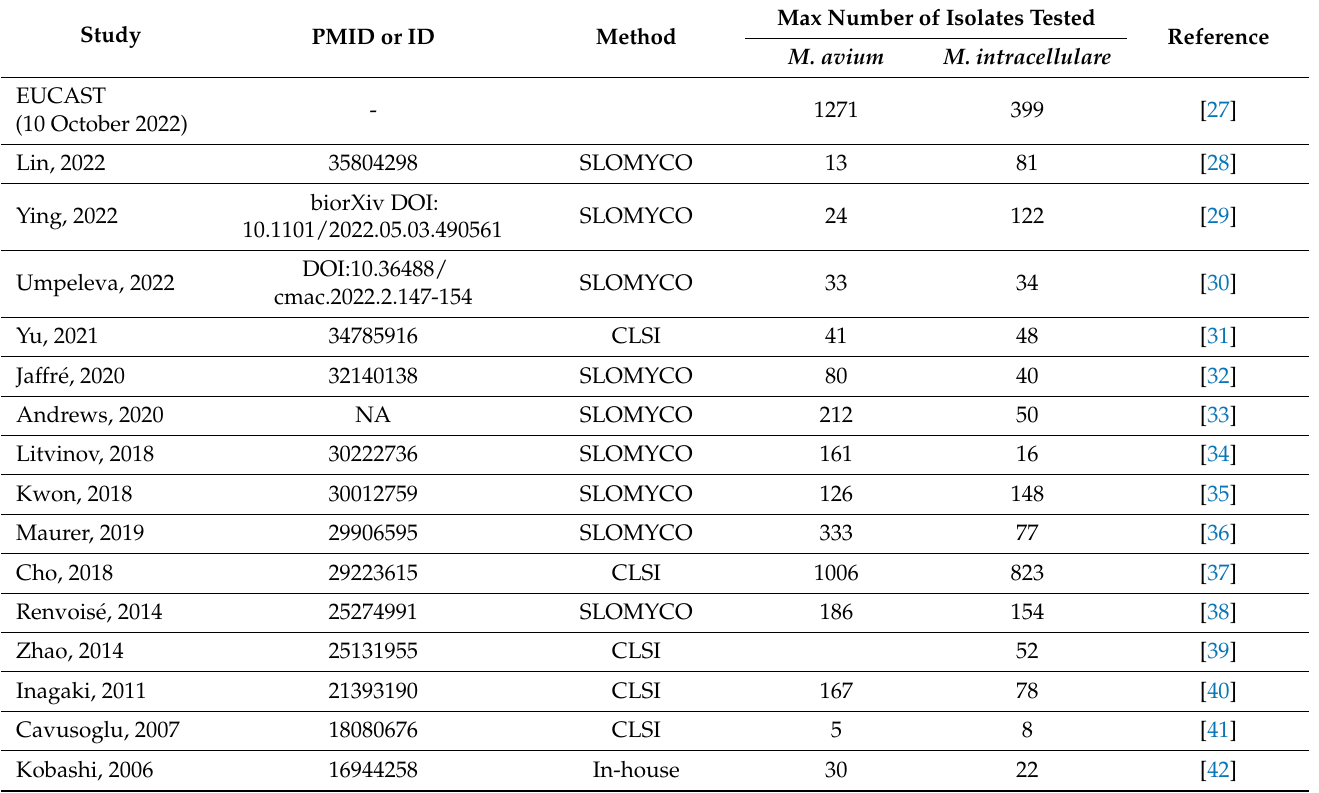
Table 1. Source of MIC data used in the